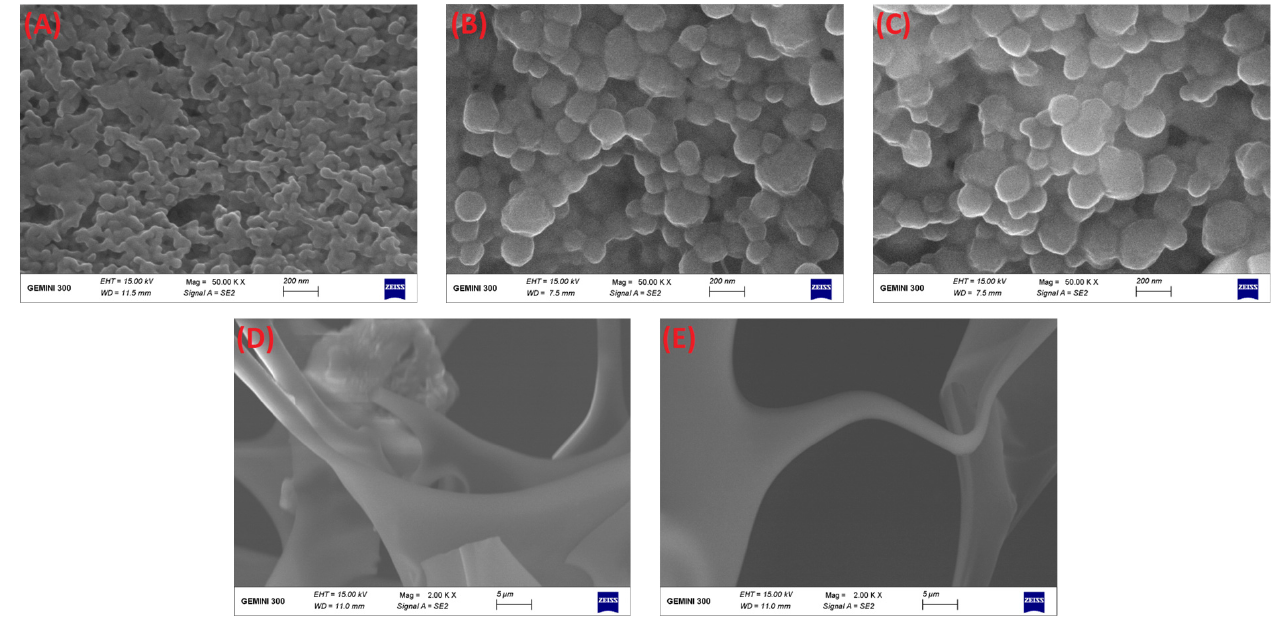
Figure 6. FE-SEM images of DHF-S/Z ( A ), DHF-CMC/S/Z ( B ), DHF-ALG/S/Z ( C ) (50,000 × magnification times), individual CMC ( D ) and ALG ( E ) (2000 × magnification times).